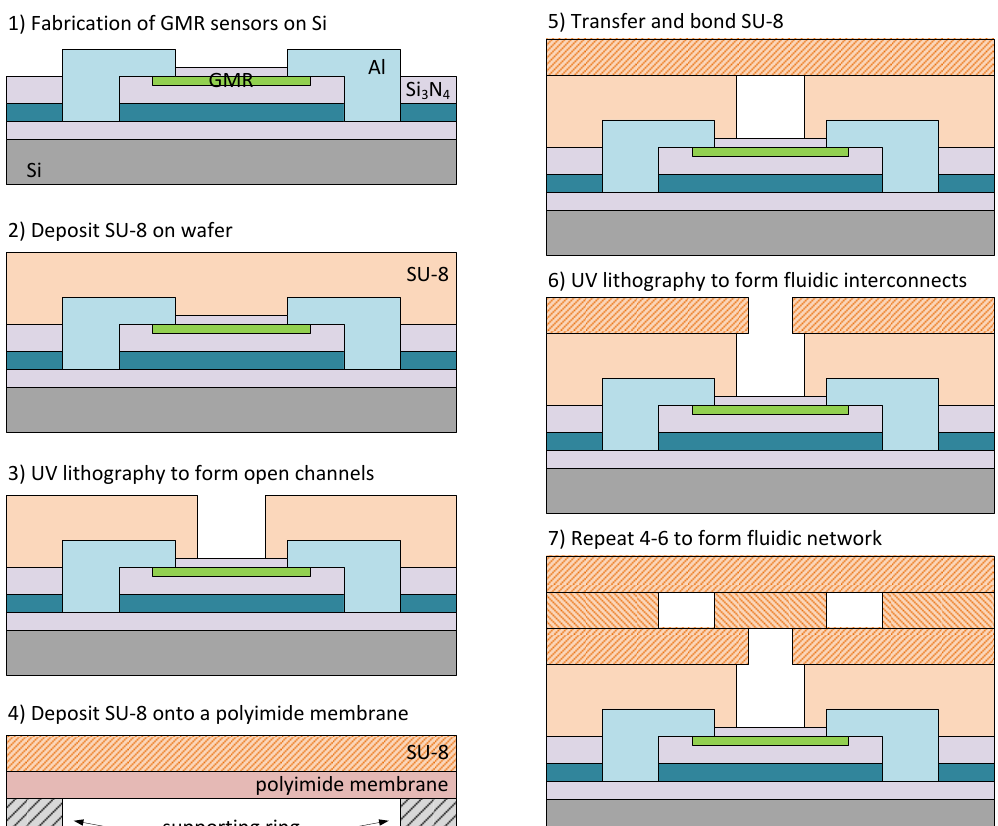
Figure 12. The process flow for integrating GMR sensors with 3-D SU-8 microfluidic system (as reported in